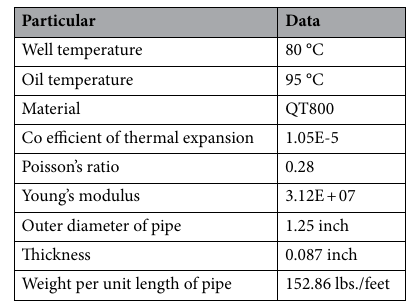
Table 20. Well data for the HOC job with the QT800